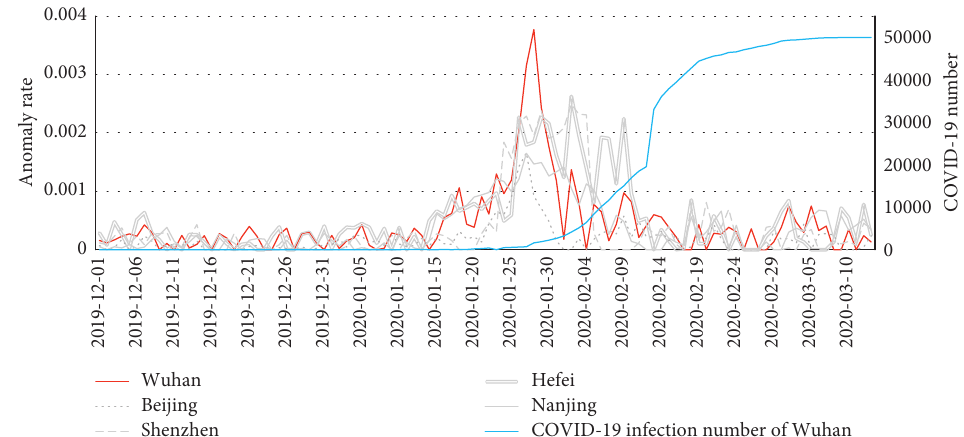
Figure 5: Predicted COVID-19 anomaly rate of 5 representative Chinese cities and the officially reported accumulating COVID-19 infection number of